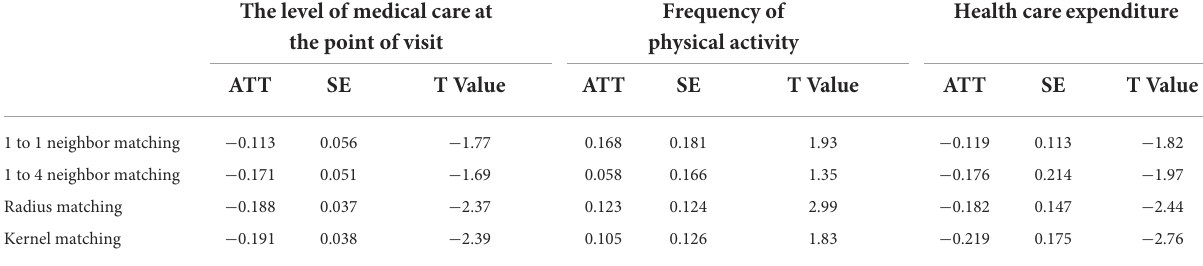
TABLE 8 Impact mechanism analyses of NRCMS on health